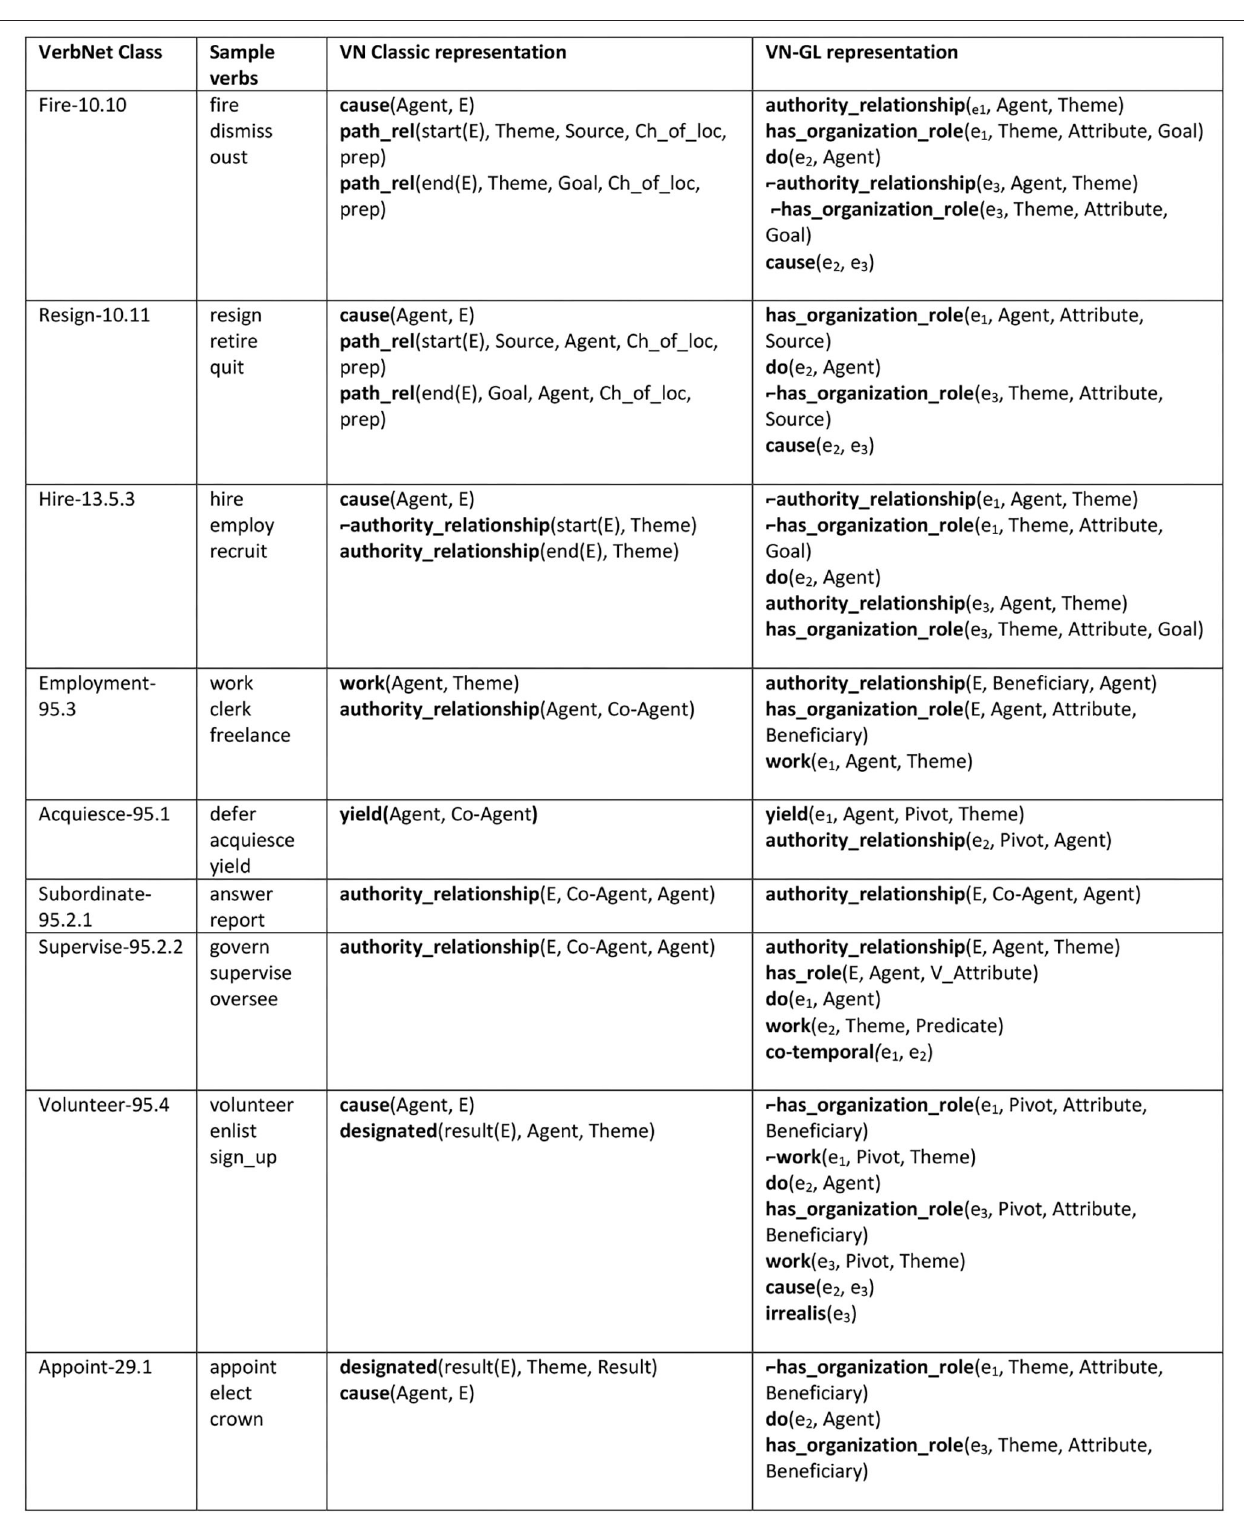
Frontiers in Artificial Intelligence |